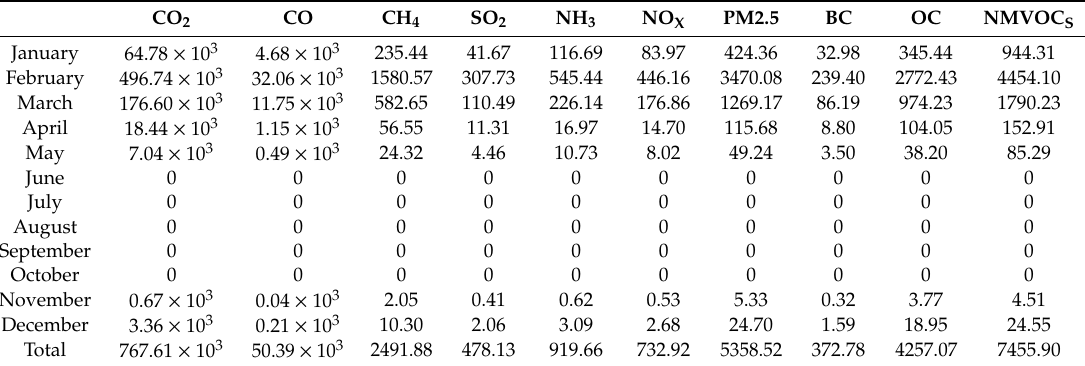
Table 3. Monthly forest fire emissions for each pollutant in 2017 (units: Mg).